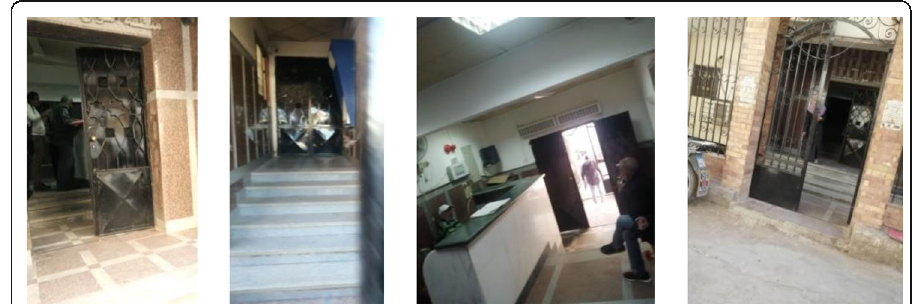
Fig. 16 The entrance does not meet the universal design principles ’ standard. Researcher,